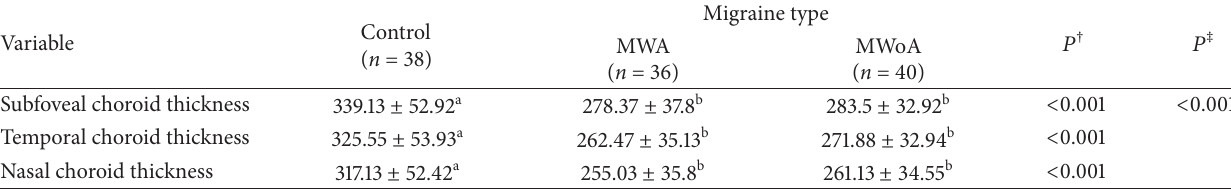
Table 3: Comparison of choroid thickness ( 𝜇 m) of the migraine types and control groups.